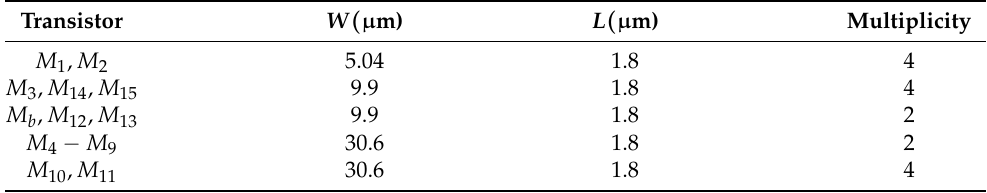
Table 2. Sizes of the OTA shown in Figure 10 to provide a gm = 800 µ A/V. Transistor